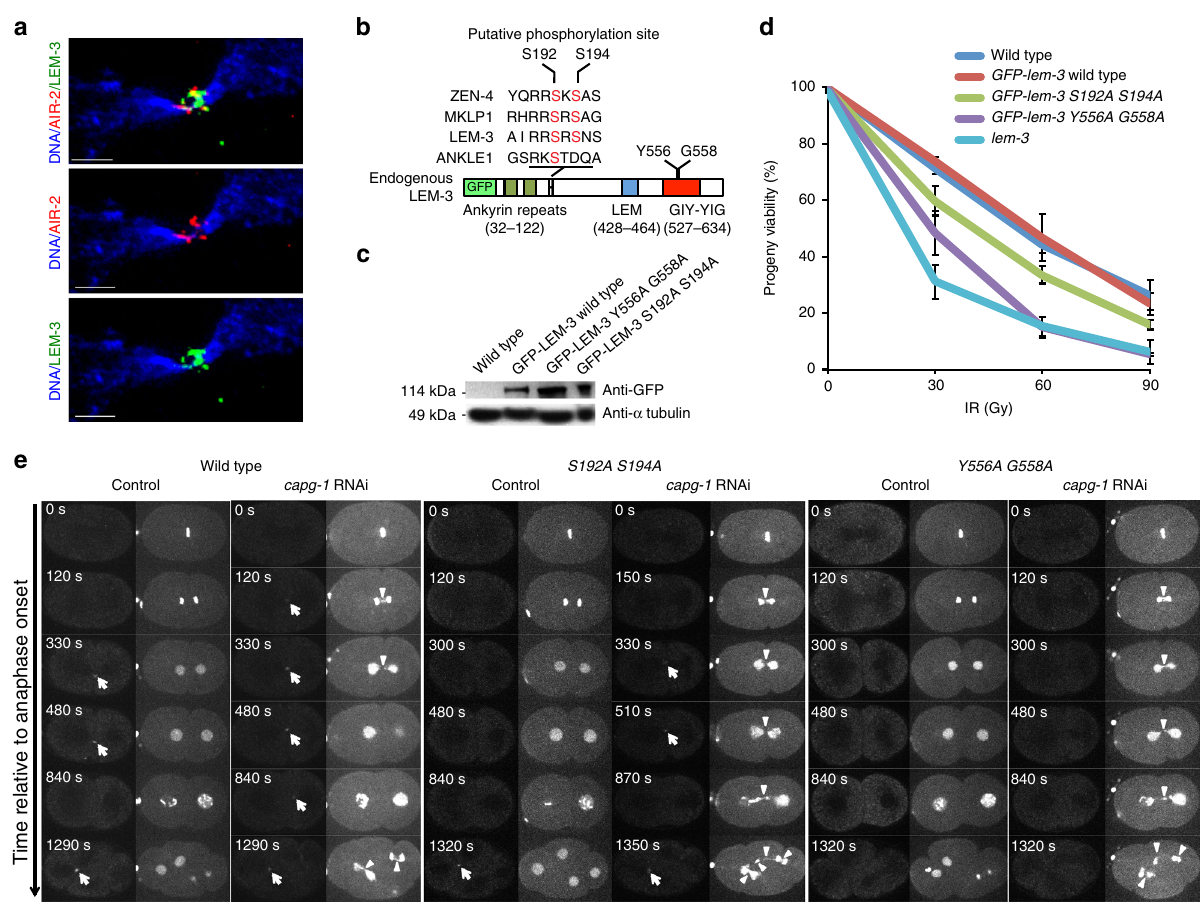
Fig. 5 Functional dissection of LEM-3 phosphorylation sites and GIY-YIG motif. a Partial co-localization of LEM-3 with AIR-2/Aurora B kinase. Co- localization was quanti fi ed by using ImageJ to calculate Manders ’ overlap coef fi cient (MOC); 77.4% (standard deviation, ±9.3%; n = 12) of the LEM-3 protein co-localized with AIR-2. AIR-2 immunostaining of representative embryos expressing GFP-LEM-3. Scale bars: 1 μ m. b Schematic presentation of endogenous GFP-LEM-3 generated by CRISPR/Cas9-mediated genome editing. The conserved Serine 192 and 194 AIR-2 putative phosphorylation sites and Tyrosine 556 and Glycine 558 in the GIY-YIG motif are indicated. c Western blot analysis of GFP-LEM-3 protein levels in GFP-LEM-3 wild type, GFP- lem-3 S192A S194A and GFP-lem-3 Y556A G558A mutants. d Sensitivity of GFP-lem-3 S192A S194A and GFP-lem-3 Y556A G558A mutants to ionizing radiation (IR). Progeny viability of lem-3 mutants after young adult nematodes were treated with IR as described in Supplementary Figure 1a. Values are the average of three independent experiments. Error bars represent standard deviation of the mean. e Analysis of chromosome segregation in GFP-lem-3 S192A S194A and GFP-lem-3 Y556A G558A mutants. Arrows indicate GFP-LEM-3. Arrowheads indicate the chromatin